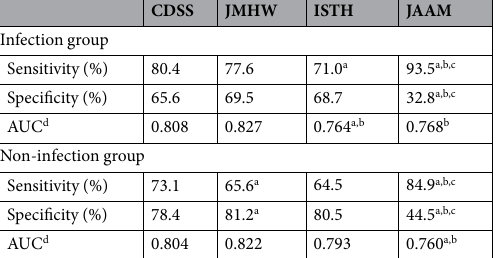
Table 4. Receiver operating characteristic (ROC) analyses for the 28-day all-cause mortality CDSS, Chinese Disseminated Intravascular Coagulation Scoring System; JMHW, Japanese Ministry of Health and Welfare; ISTH, International Society on Thrombosis and Haemostasis; JAAM, Japanese Association for Acute Medicine; AUC, area under the ROC curve. a p < 0.05 vs. CDSS; b p < 0.05 vs. JMHW; c p < 0.05 vs. ISTH; d p < 0.001 for each AUC.